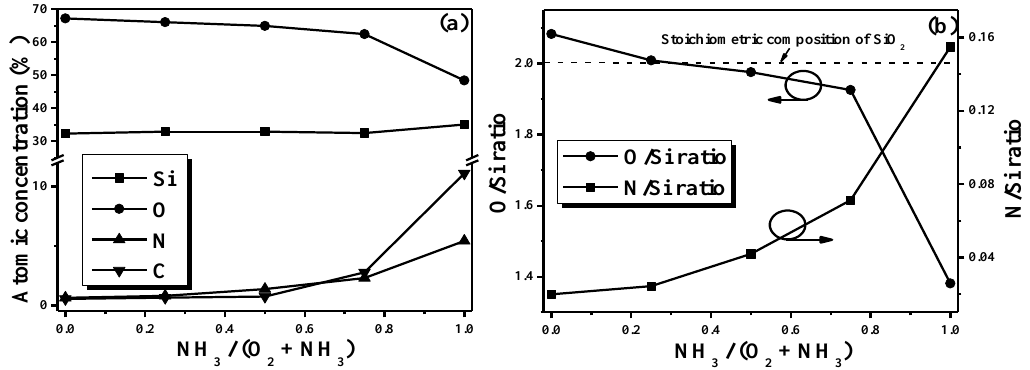
Figure 4. ( a ) Atomic concentrations and ( b ) the ratios of O/Si and N/Si for the films synthesized from various gas flow ratios measured by X-ray photoelectron (XPS).